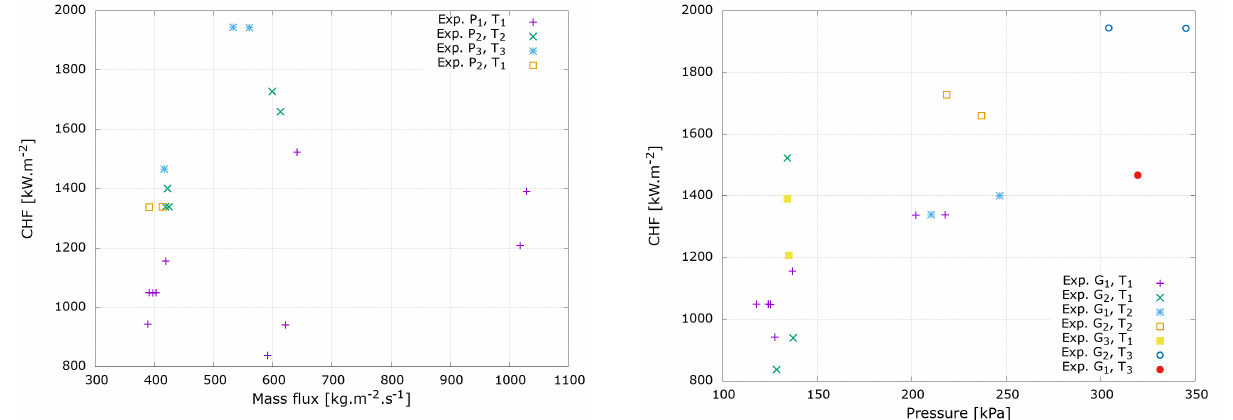
Figure 4. CHF against inlet mass flux with different inlet pressure and temperature according to Tab. 2.